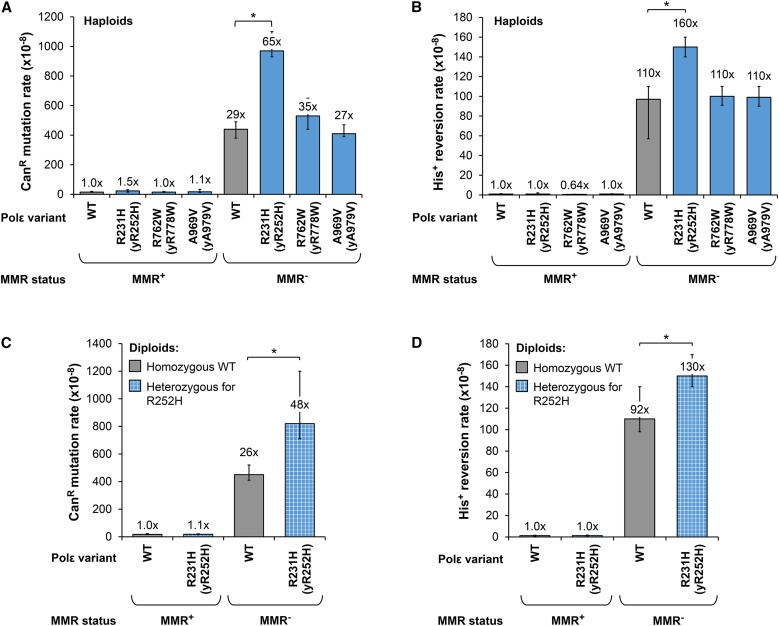
Effects of Polε variants found in MMR-deficient tumors on the mutation rate in MMR-deficient background. Mutation rates were measured in haploid (A and B) or diploid (C and D) strains containing chromosomal pol2 mutations indicated on the x-axis. The MMR defect was mimicked by deleting the yeast MLH1 gene. Mutation rates are given as the median for at least 18 independent cultures, with error bars indicating 95% confidence intervals. Fold increase in mutation rate relative to the strain with wild-type POL2 and MLH1 genes is shown above each bar. Asterisks indicate P < 0.05 by Wilcoxon–Mann–Whitney test. Data are from Table S7 in File S1.